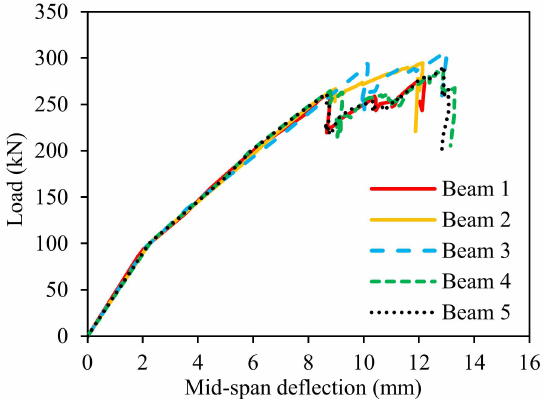
Figure 11. Results of the load–displacement curves of the five reinforced concrete beams. The cracks in the concrete are quantitatively represented by a tension damage index, which is denoted by DAMAGET. DAMAGET is in the range of 0 to 1: 0 means there is no tension damage (i.e., crack), and 1 means the concrete is completely cracked. Figure 12 shows the finite element analysis results of the development of cracks in Beam 3 with the increase of the displacement applied to the beam. With the increase of the displacement, the cracks in concrete are initiated from the mid-span section and then developed toward the two ends of the beam. The cracks are mainly flexural cracks located within the flexural span. After the flexural cracks were developed to a certain level, diagonal shear cracks were generated in the shear spans.